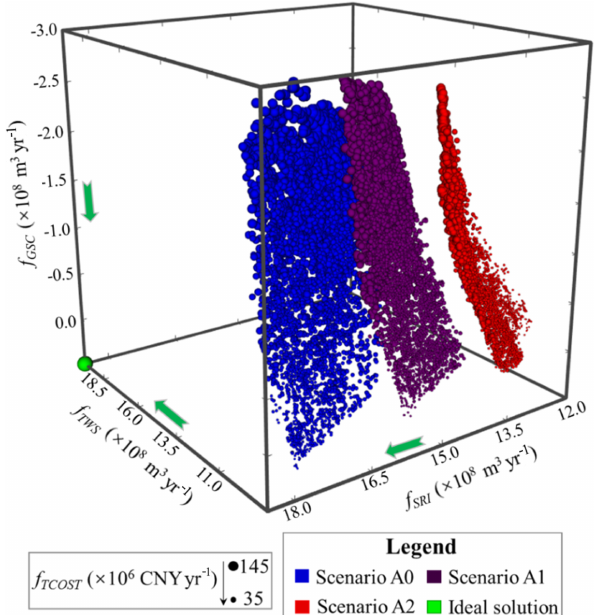
Figure 11. The trade-off solutions under scenarios A0 (maintain current runoff), A1 (reduce the runoff by 10%), and A2 (reduce the runoff by 20%). The sphere size indicates the value of f TCOST . The green arrow is the direction of better performance for each objec- tive.